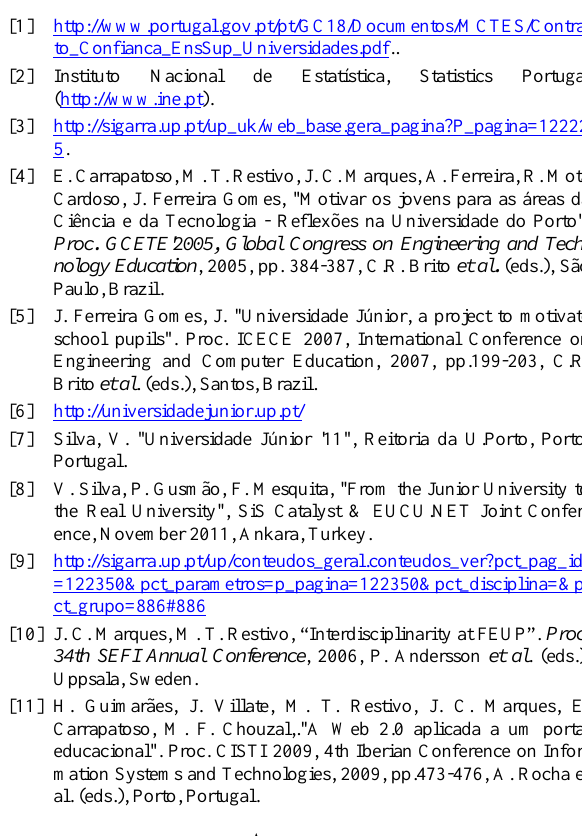
TABLE IV. S TATISTICS OF THE 1 ST PHASE OF APPLICATION TO FEUP FOR 1 ST YEAR STUDENTS